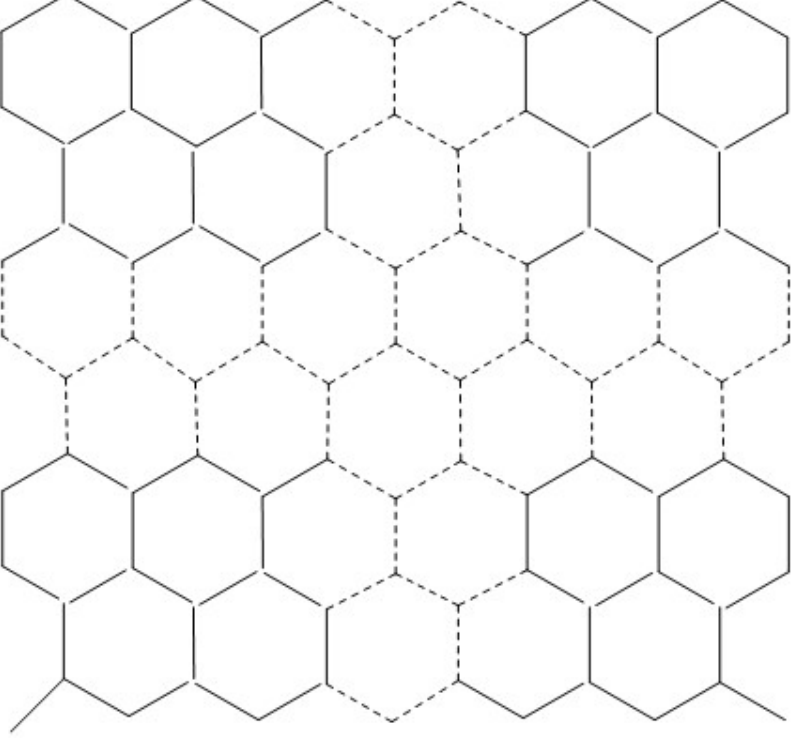
cuts from the regular hexagonal m